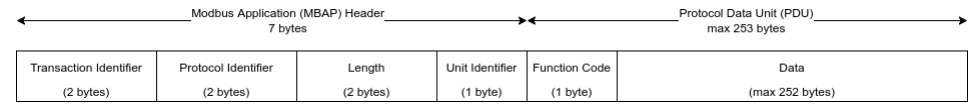
Figure 7. Modbus TCP/IP frame.